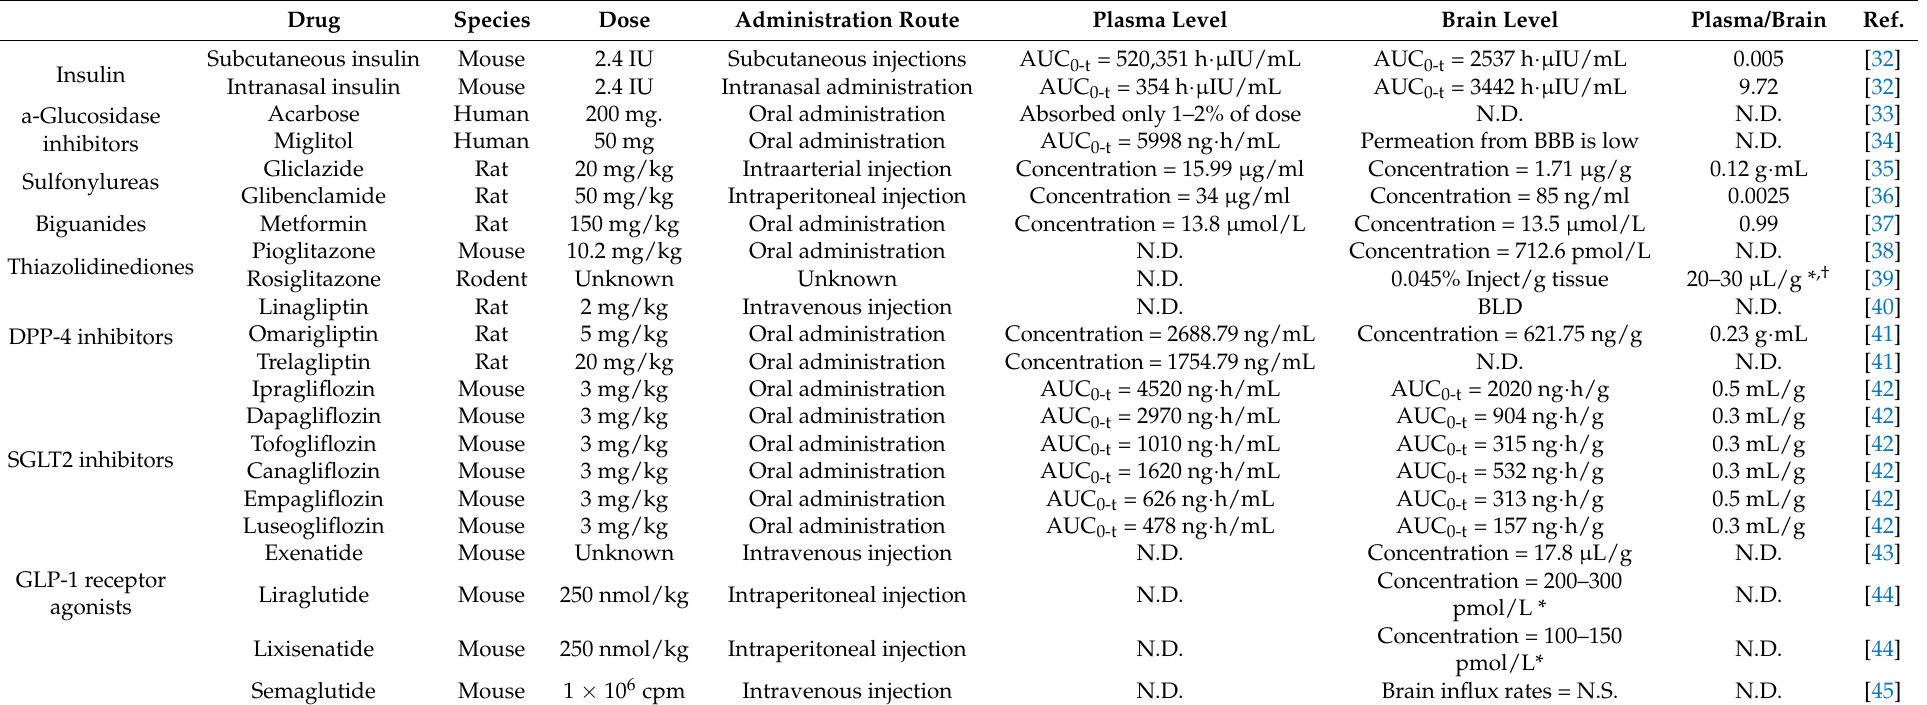
Table 2. The BBB permeability of antidiabetic